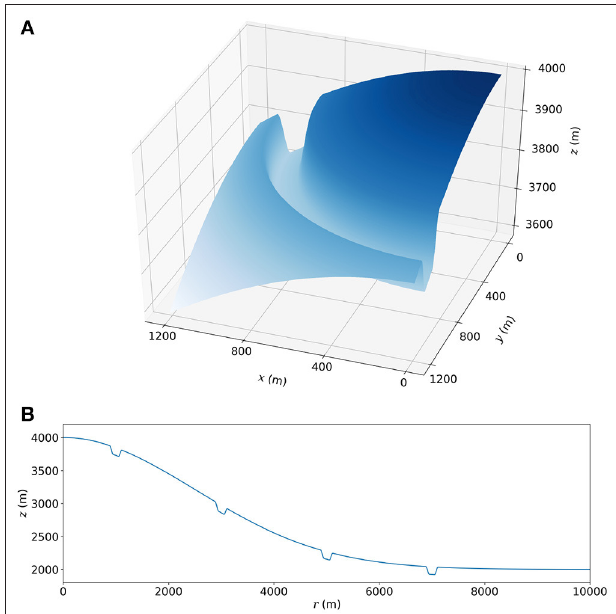
FIGURE 4 | Two opposing slopes introduced onto the Gaussian-sloped edifice, in (A) 3D and (B) 2D axisymmetric space.